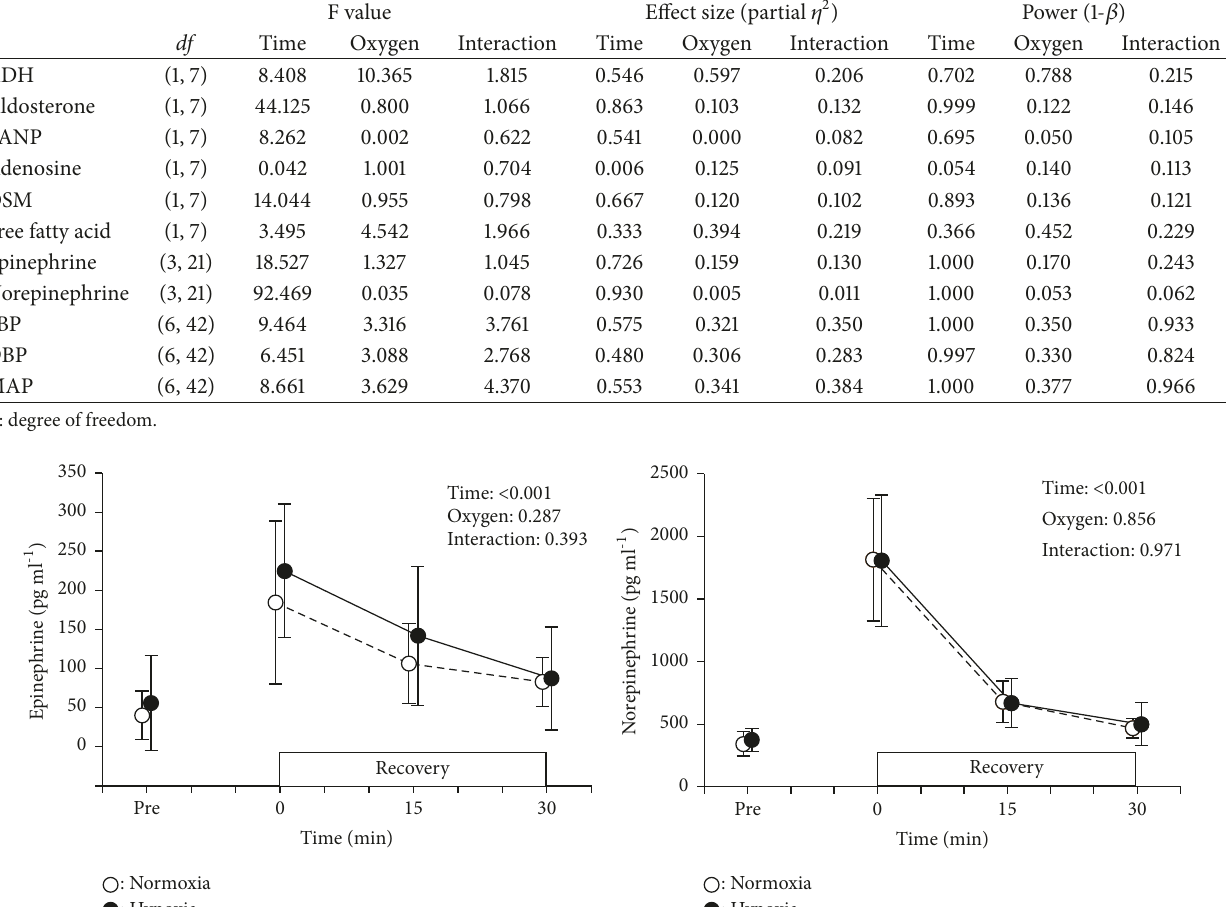
Table 2: Summarized results of statistical analysis in the subset of outcomes.